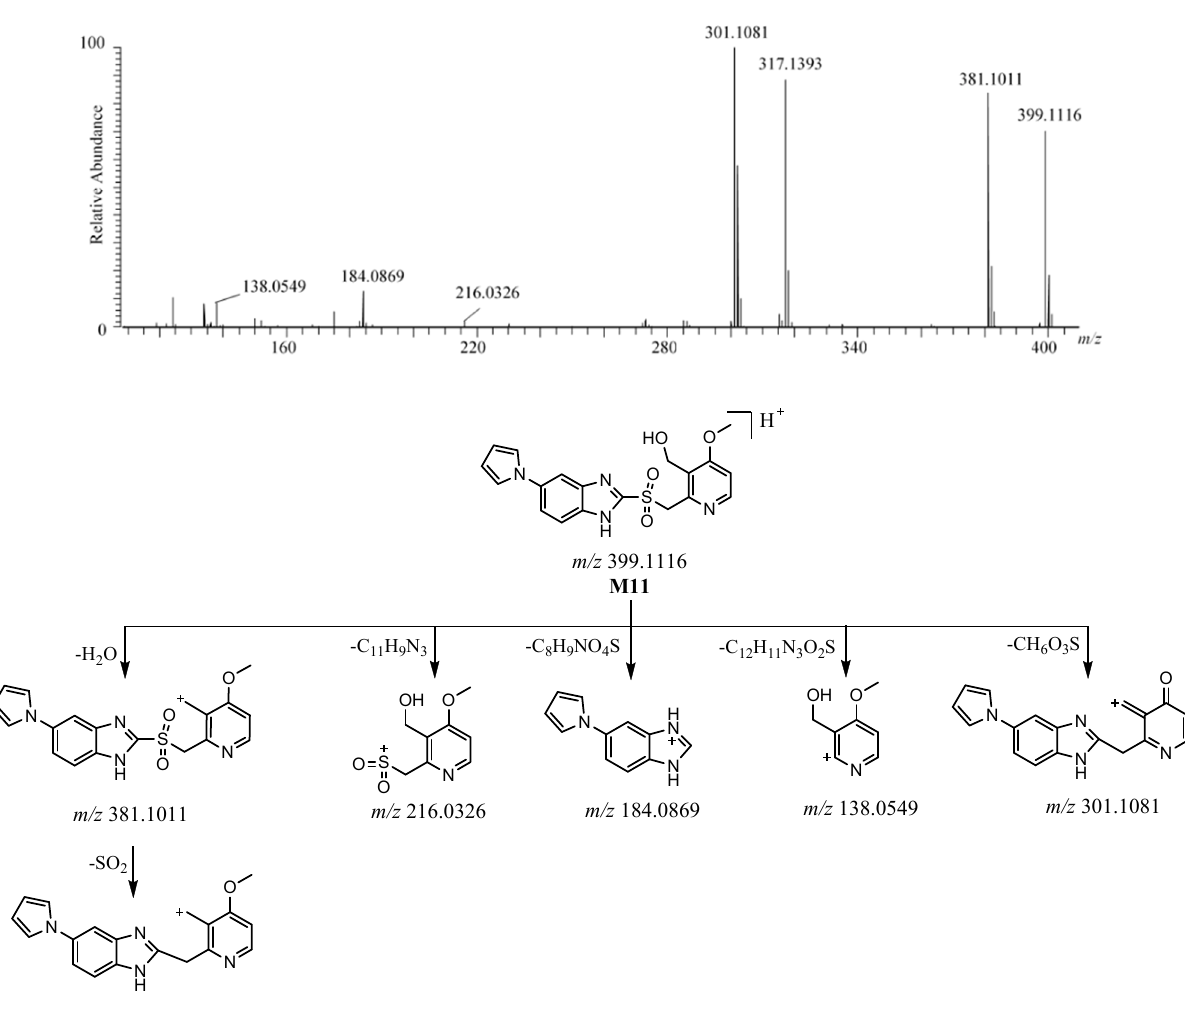
Figure 10. The HRMS/MS spectrum and the possible fragmentation pathway of M11.